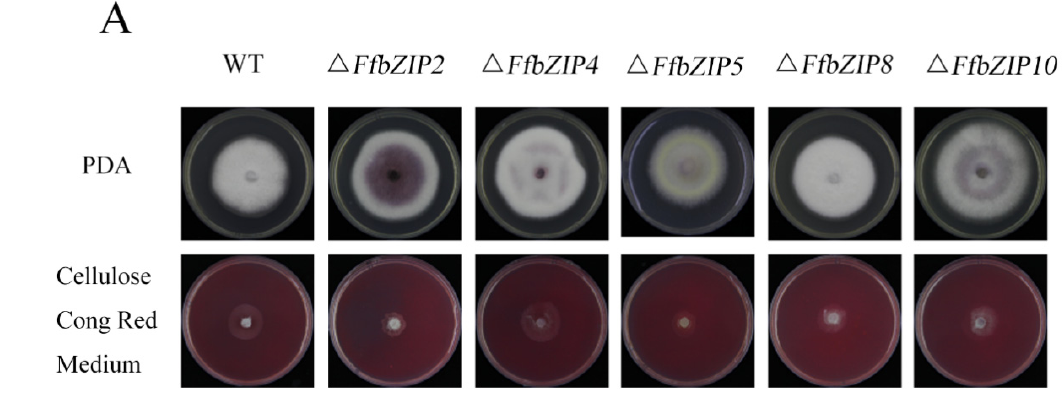
Figure 7. Cell wall selection pressure experiment. ( A ) Growth of wild type and FfbZIP knockout mutants under cell wall selection pressure. ( B ) Histogram of strain diameter under 1 mol/L E420 cell wall selection pressure. Error bars represent means ± SEs. ( C ) Histogram of strain diameter under 2 mol/L E420 cell wall selection pressure. Error bars represent means ± SEs, * p < 0.05, ** p < 0.01.